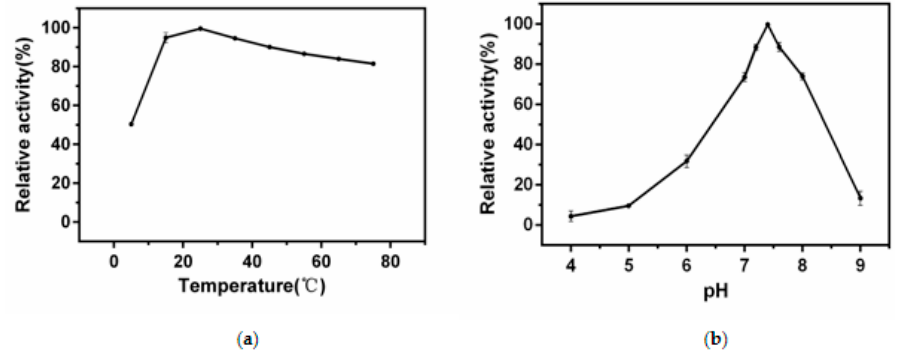
Figure 2. Effect of temperature and pH on the catalytic activity of Dh–A–H–E. ( a ) The reaction was carried out at different temperatures (5–75 °C) and the peroxidase activity of Dh–A–H–E was measured according to the standard assay in Section 3.3. ( b ) The reaction was carried out under various pH levels (4–9) and the peroxidase activity of Dh–A–H–E was measured according to the standard assay in Section 3.3. The catalytic activity at pH 7.4 and 25 °C is taken as 100%, and experiments were performed in triplicate to obtain the mean value.